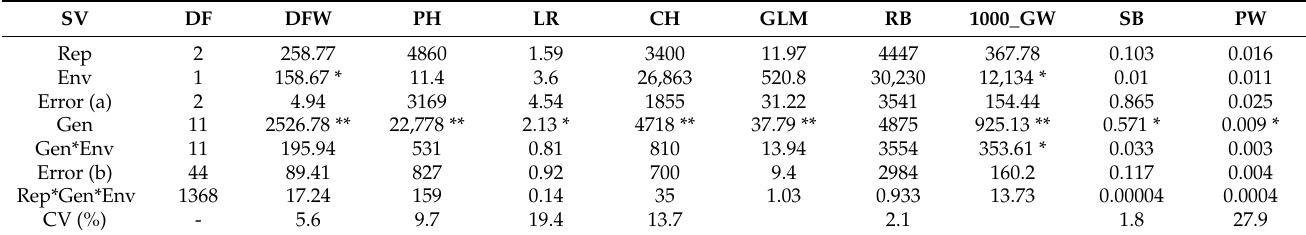
Table 7. Mean squares and significance test effect of water stress and nonstress on sorghum genotypes. SV DF